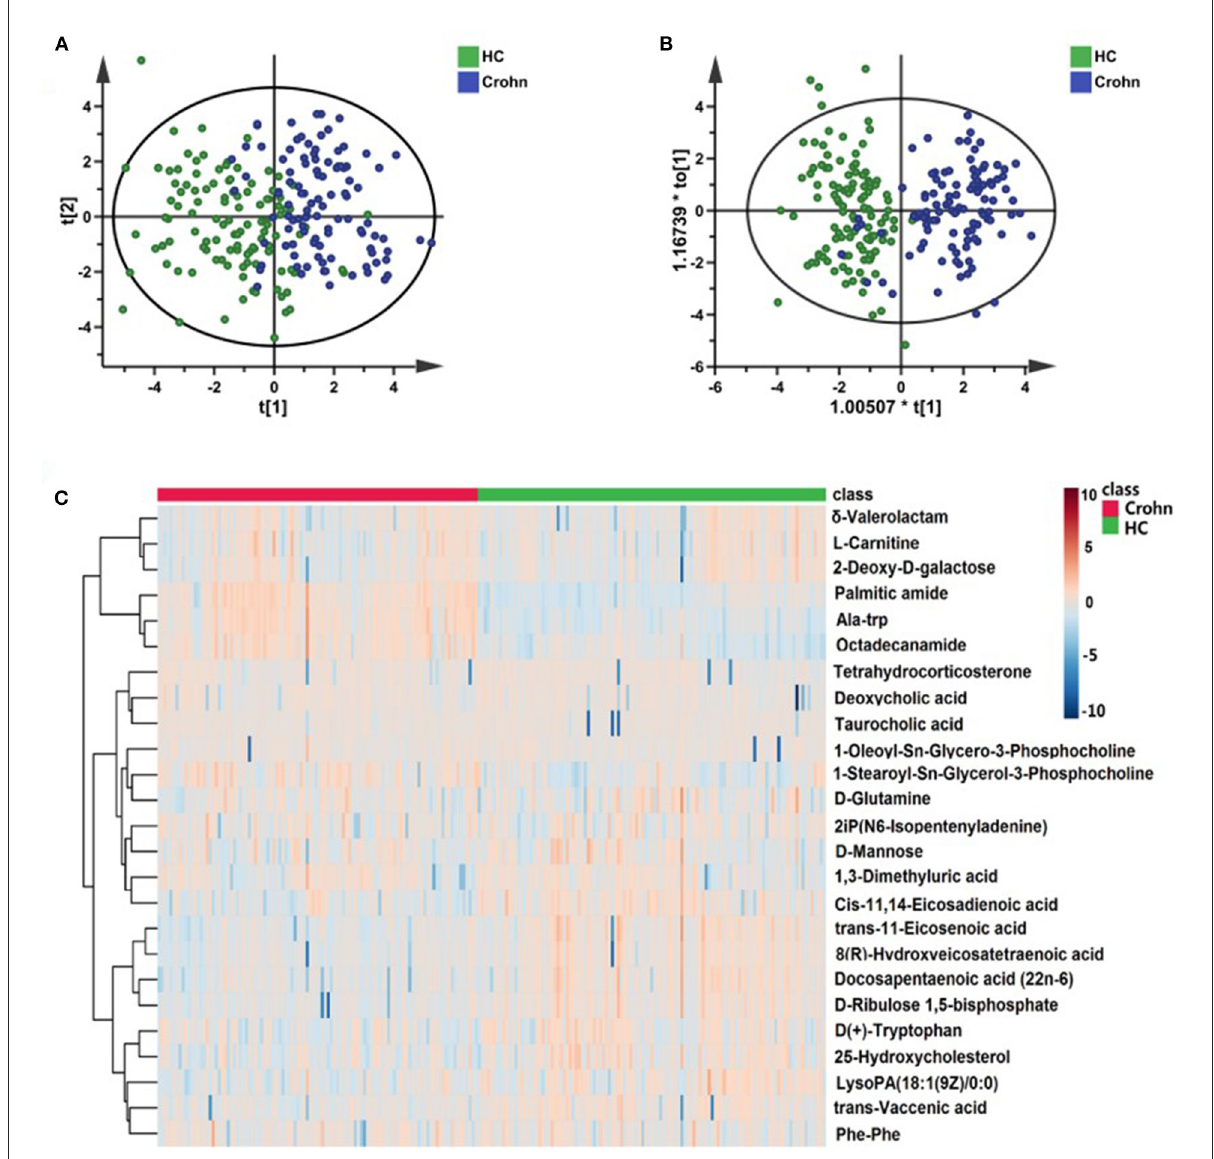
FIGURE3 The performance of 25 differential metabolites for classification in the discovery set. (A) Heatmap of cluster analysis of each metabolite. (B) The scatter plot of PCA analysis was based on 25 metabolites. (C) The OPLS-DA scatter plot of 25 metabolites.